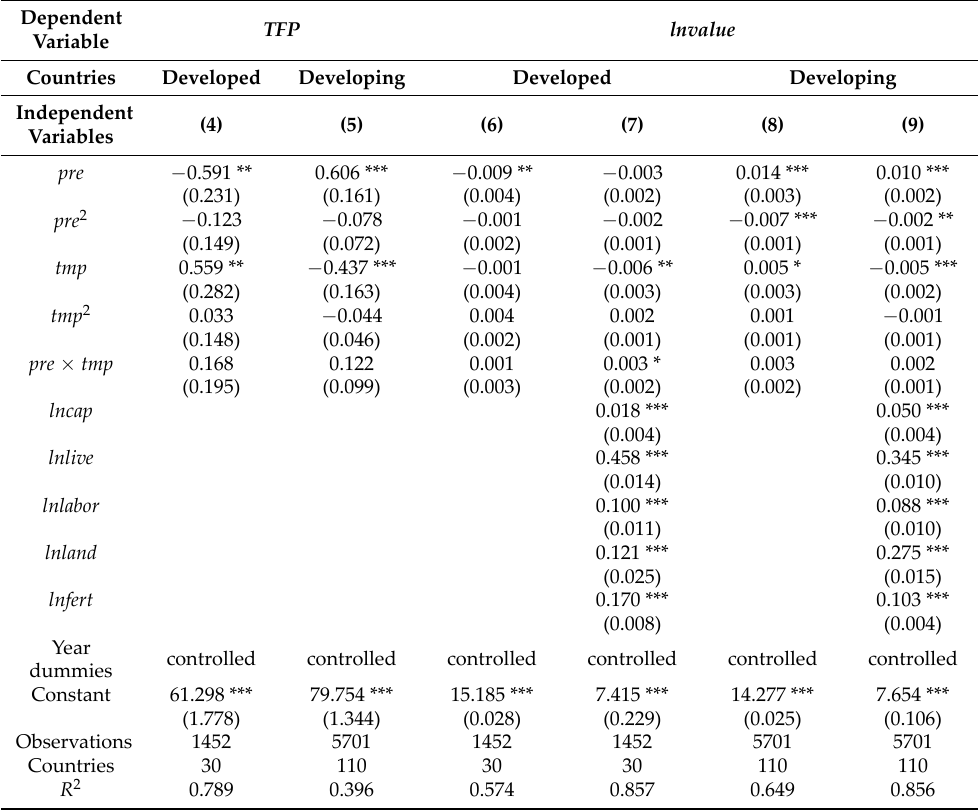
Table 5. Impact of climate change on countries with different development